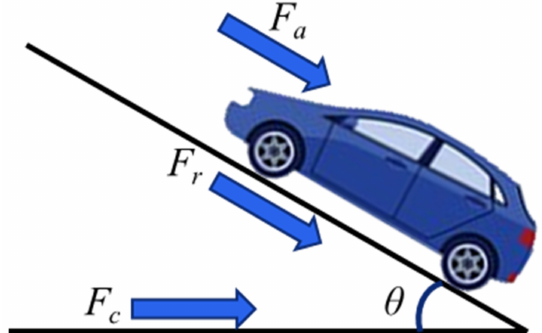
Figure 7. Relation between vehicle and driving loads.